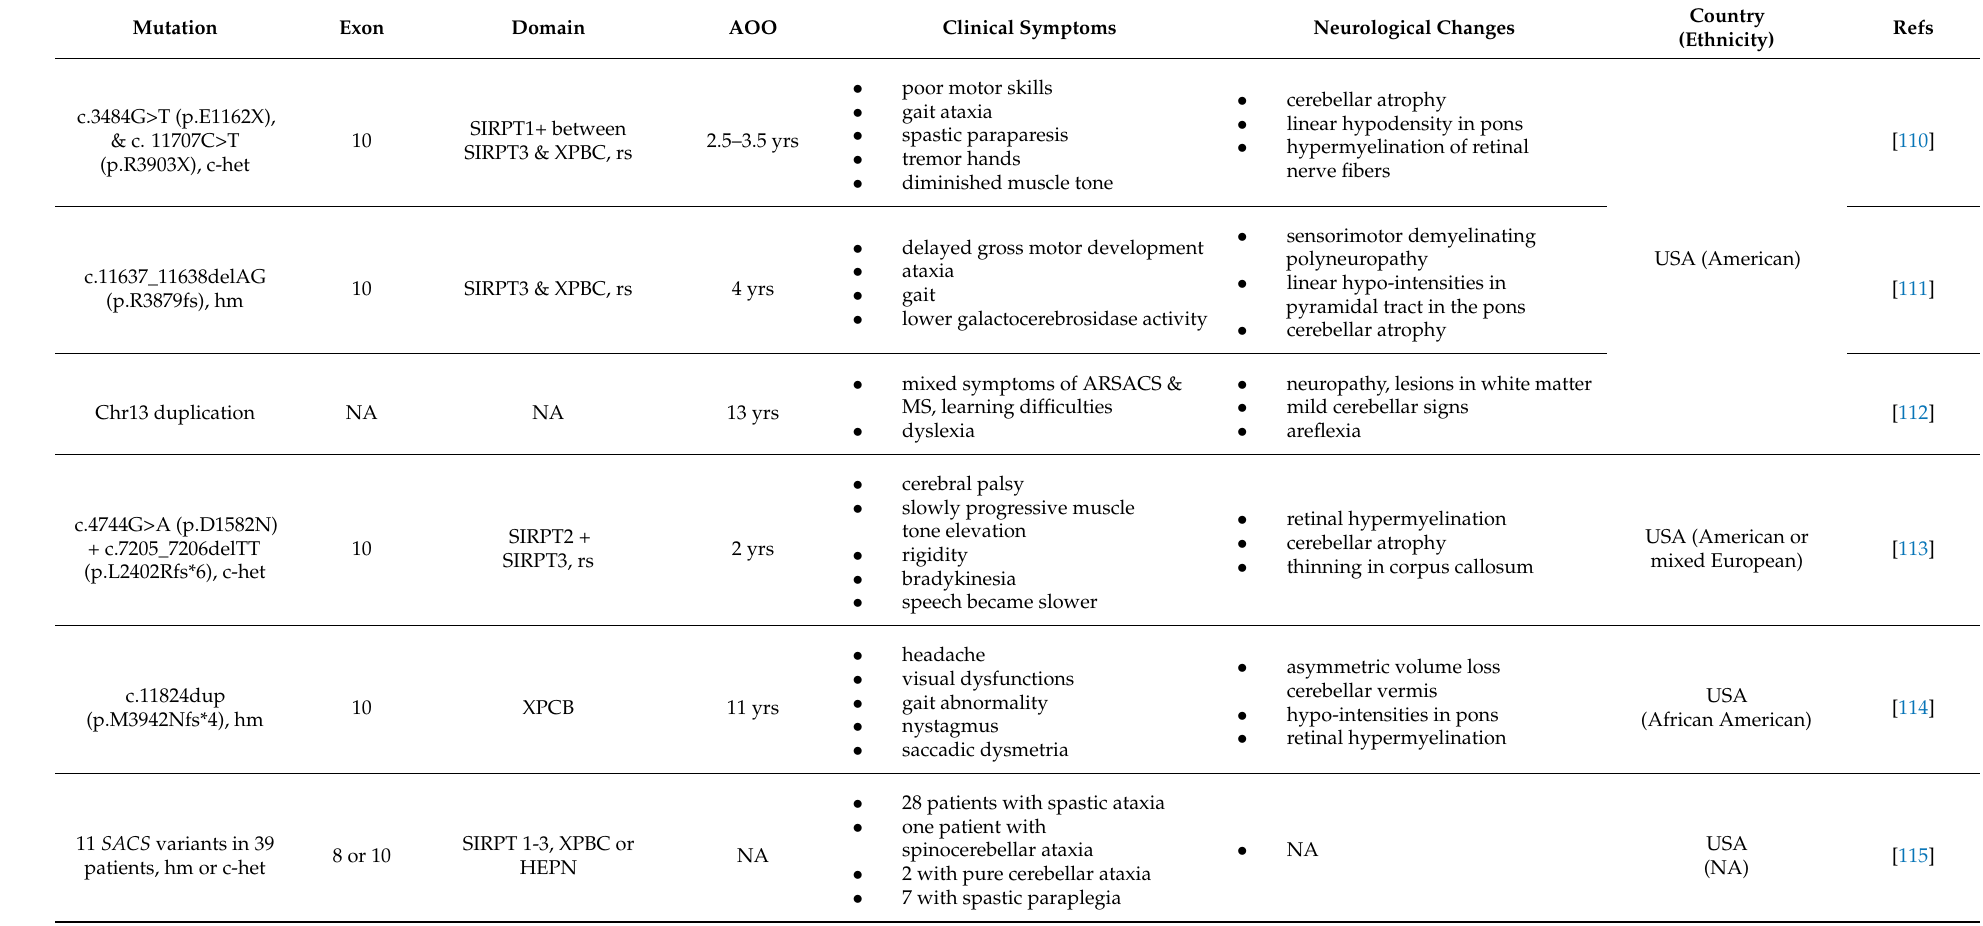
Table 4. SACS mutations discovered in USA, South America and New Zealand. “hm” means mutation carried the homozygous form, “c het” means mutation had compound heterozygous allele. “rs” means